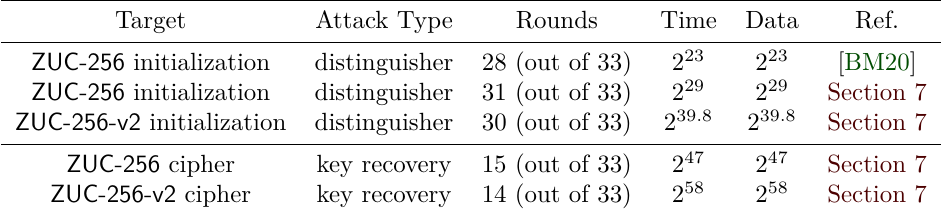
Table 1: Summary of the attacks on ZUC-256 and ZUC-256-v2 , where at least 16 key bits are recovered in the key-recovery attacks. All the attacks are in the related-key setting. In addition, when the target is the initialization phase, attackers can access some internal state bits. When the target is the actual cipher, attackers can only access the keystream